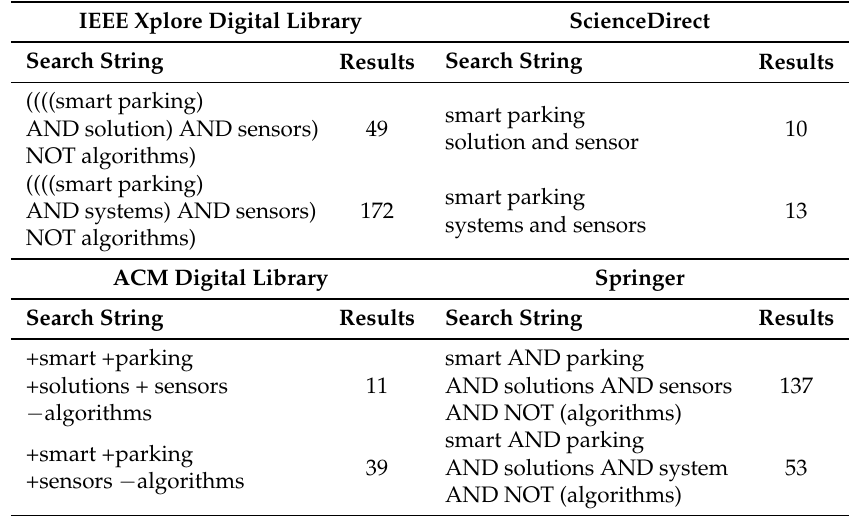
Table 1. IEEE Xplore Digital Library, ScienceDirect, ACM Digital Library, and Springer query